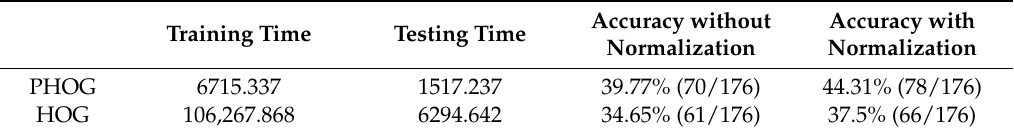
Table 4. Training time, testing time and accuracy for PHOG and HOG.